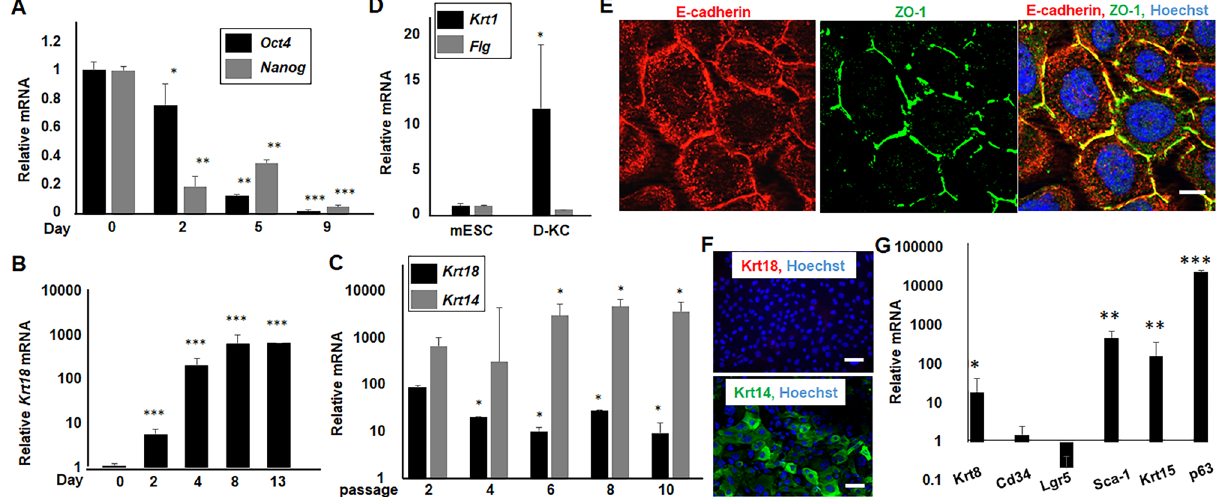
Figure 2. Molecular tracing of the in vitro differentiated cells. ( A , B ) Cells at different days of differentiation were examined for gene expression by RT-PCR. The expression of ( A ) the stem cell markers Oct4 and Nanog, and ( B ) the ectoderm marker Krt 18 were compared to the levels in undifferentiated mESCs, i.e. day 0. ( C ) Cells at different passages were examined for mRNA of Krt 18 and Krt 14. The expression of Krt 18 was significantly decreased while the expression of the basal keratinocyte marker Krt 14 was significantly increased with the increase of passages. High level Krt 14 expression was stabilized at passage 6 onward. These cells are so forth termed differentiated-keratinocyte (D-KC). Compared to mRNA levels in mESCs, the D-KC had ( D ) elevated expression of the spinous cell marker Krt 1, but not the cornified envelop marker Flg , and ( G ) a slight increased Krt 8 , no change of hair follicle stem cell markers, Cd34 and Lgr5 , and significant increase of the epidermal progenitor markers Sca-1 , Krt15 and p63 . D-KC were subjected to immunofluorescence staining for ( E ) the adherence junction (E-cadherin) and tight junction (ZO-1), and ( F ) anti-Krt 18 and anti-Krt 14. nucleus was stained with Hoechst 33,342 (blue). * p < 0.05, ** p < 0.01, *** p < 0.001 were considered statistically significant compared to day 0 or passage 2. Scale bar represents 20